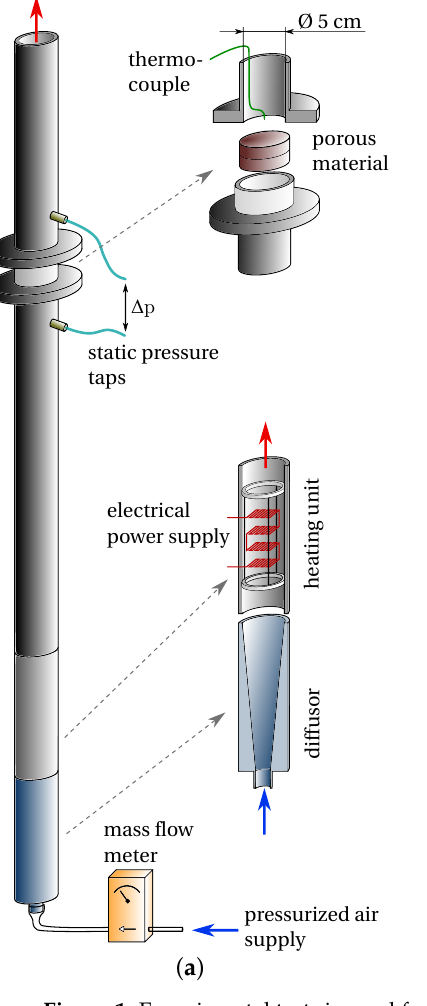
Figure 1. Experimental test rig used for specifying porous material properties at varying temperatures ( a ). Pressurized air is forced through a cylindrical material sample ( b ) and the static pressure drop is recorded. The porous material is metallic foam with a nominal pore diameter of d p = 800µm ( c